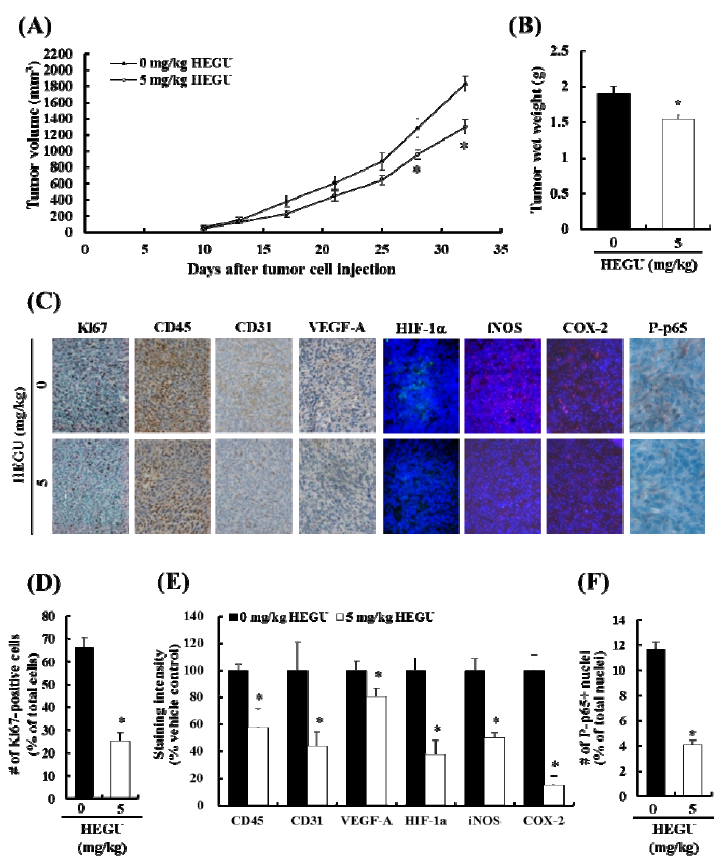
Figure 1. Glycyrrhiza uralensis (HEGU) in drinking water inhibits solid tumor growth and decreases cell proliferation and the expression of proteins related to angiogenesis and inflammation in 4T1